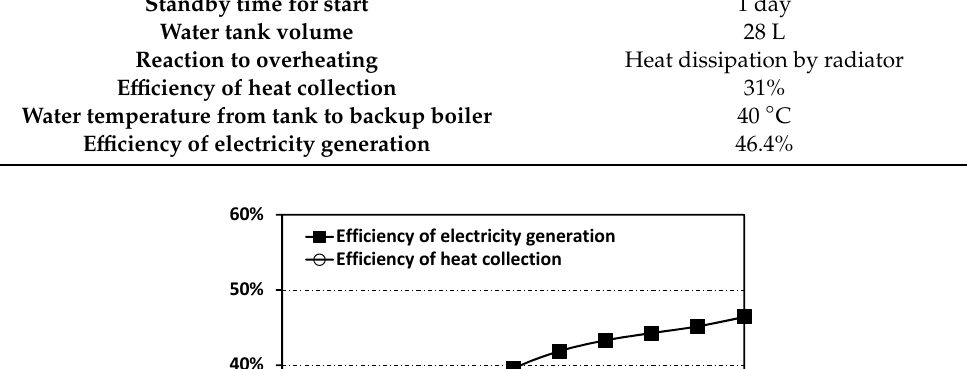
Figure 5. Efficiency of the SOFC–CGS. Table 6. Specifications of the SOFC–CGS.